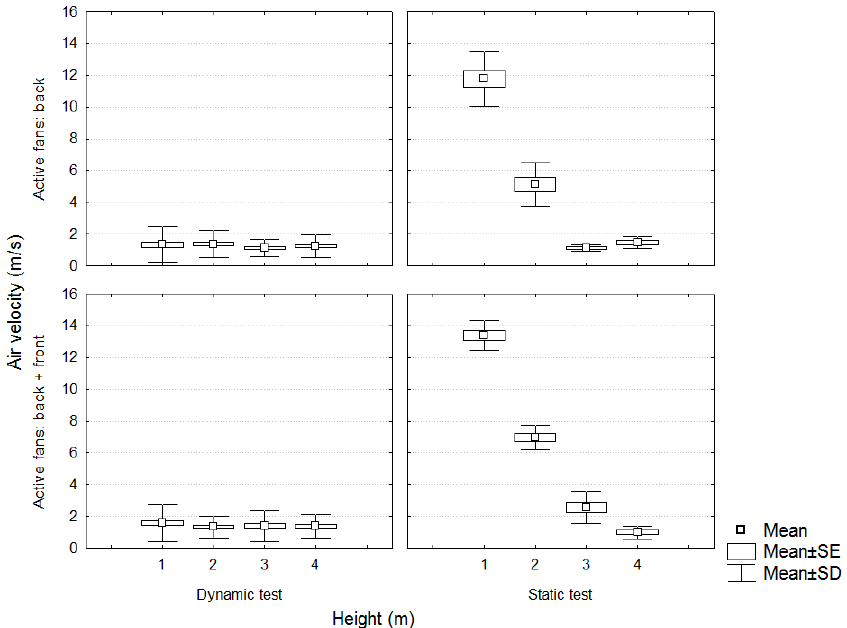
Figure 15. Dynamic versus static test. Fan blades position = 3. Air velocity values in function of the measurement height and the number of active fans. Static values measured in section C.